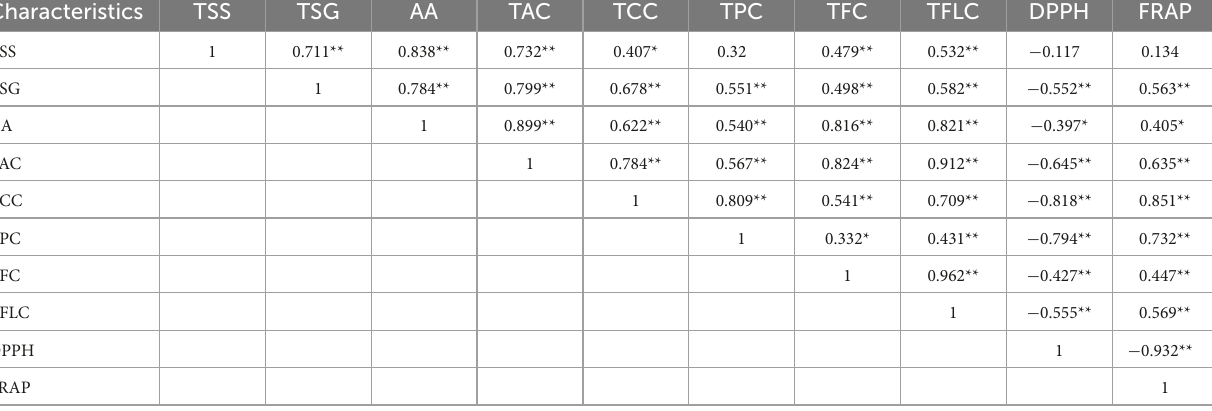
TABLE 5 Color, season of availability and market price of wild edible fruits grown in the eastern Himalayas, India. Fruits Peel pigmentation Juice pigmentation Season of